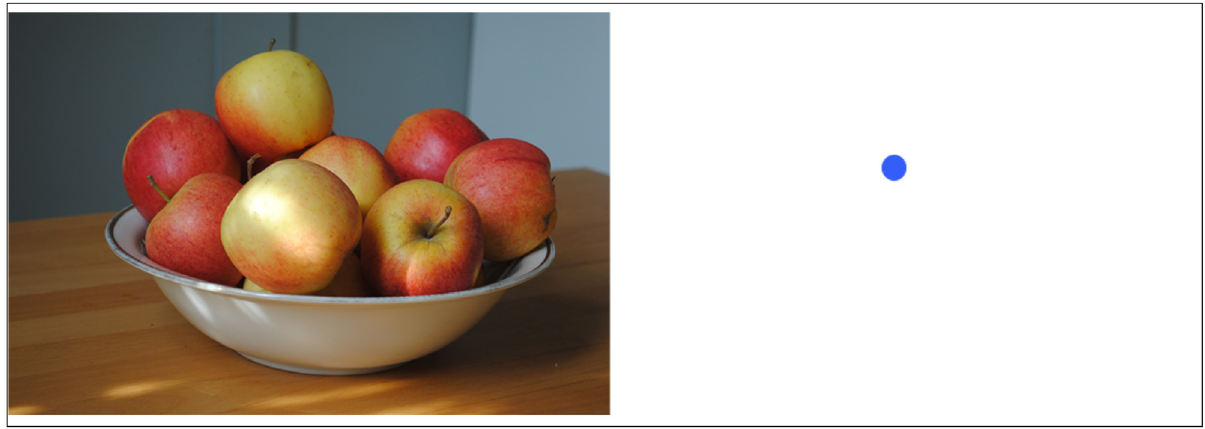
Fig 1. Example of a single frame within a trial. The originalresolutionof the image (fitting the wholescreen) was changedfor illustrative purposes. To the left, an image representative of the static stimuli (this photographdoes not come from the IAPS, as IAPS photographs cannot be published. The author of this photographis MEK). To the right, a singleframe from the video clip (dynamic stimulus) showingthe position of the dot.